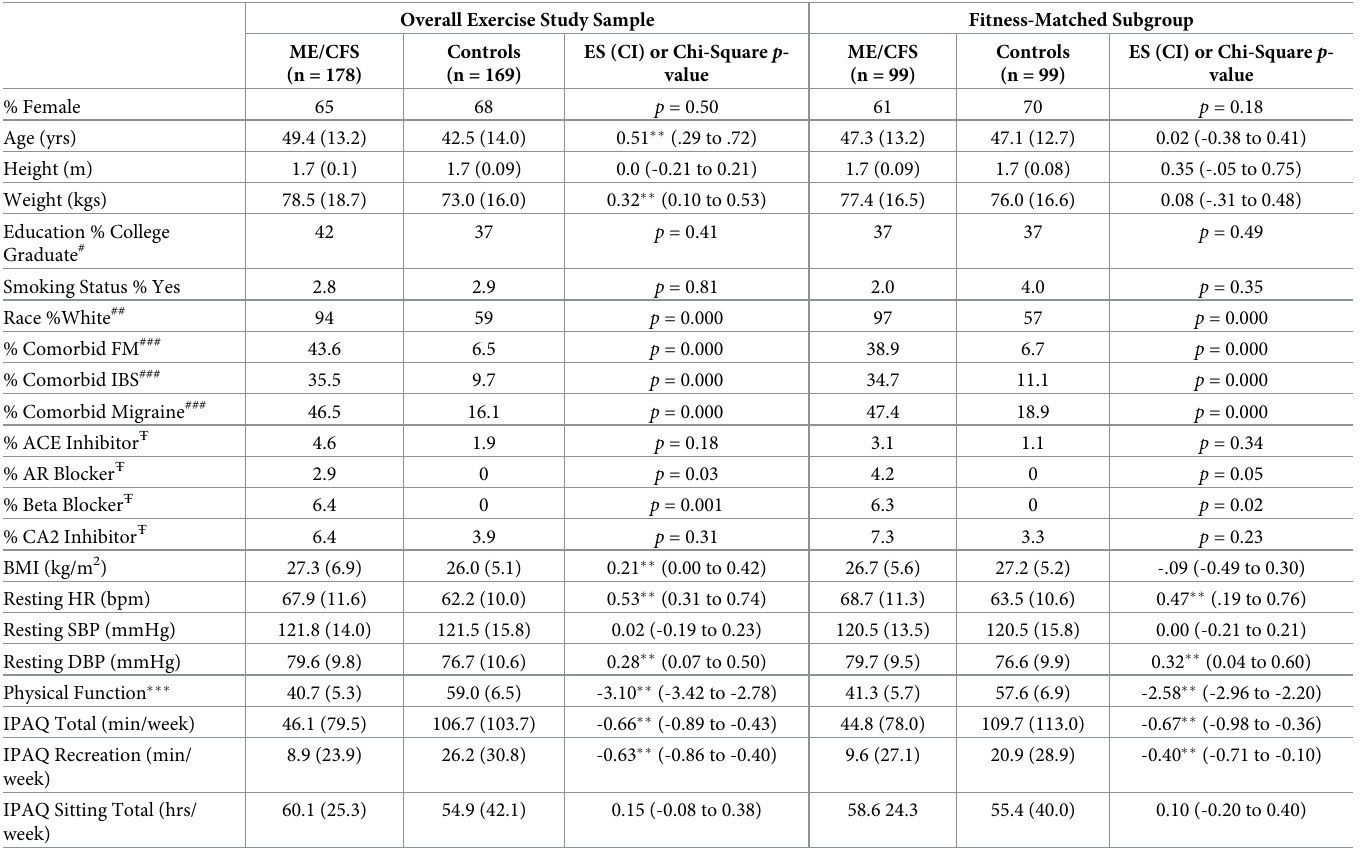
Table 1. Demographic and baseline data � for ME/CFS patients and controls. Overall Exercise Study Sample Fitness-Matched